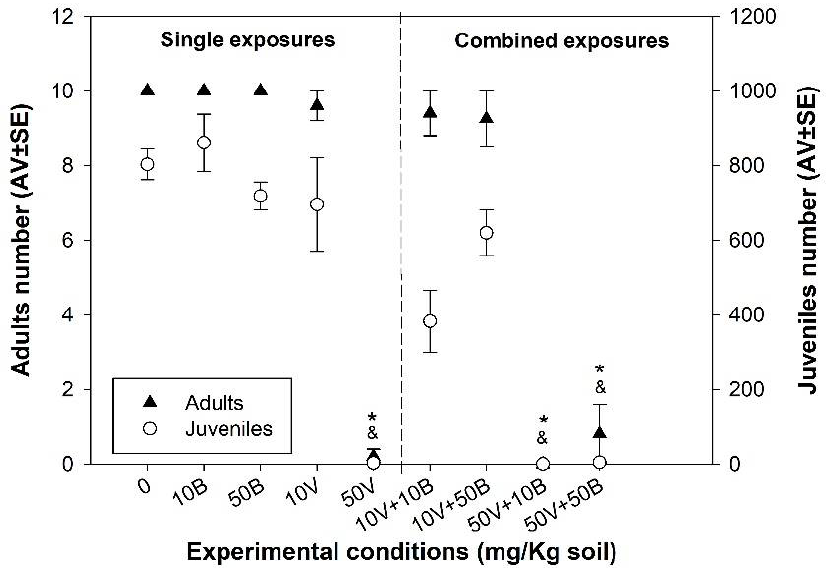
Figure 1. Effects on Enchytraeus crypticus survival (adult number) and reproduction (juvenile number) after 28 days exposure to: 0—control and solvent control; 10B—10 mg BNPs/kg soil; 50B—50 mg BNPs/kg soil; 10V—10 mg VNPs/kg soil; 50V—50 mg VNPs/kg soil; 10V + 10B—10 mg VNPs + 10 mg BNPs/kg soil; 10V + 50B—10 mg VNPs + 50 mg BNPs/kg soil; 50V + 10B—50 mg VNPs + 10 mg BNPs/kg soil; 50V + 50B—50 mg VNPs + 50 mg BNPs/kg soil, in LUFA 2.2 soil. Results are expressed as average value (AV) ± standard error (SE) ( n = 4). *—Significant differences in the number of adults